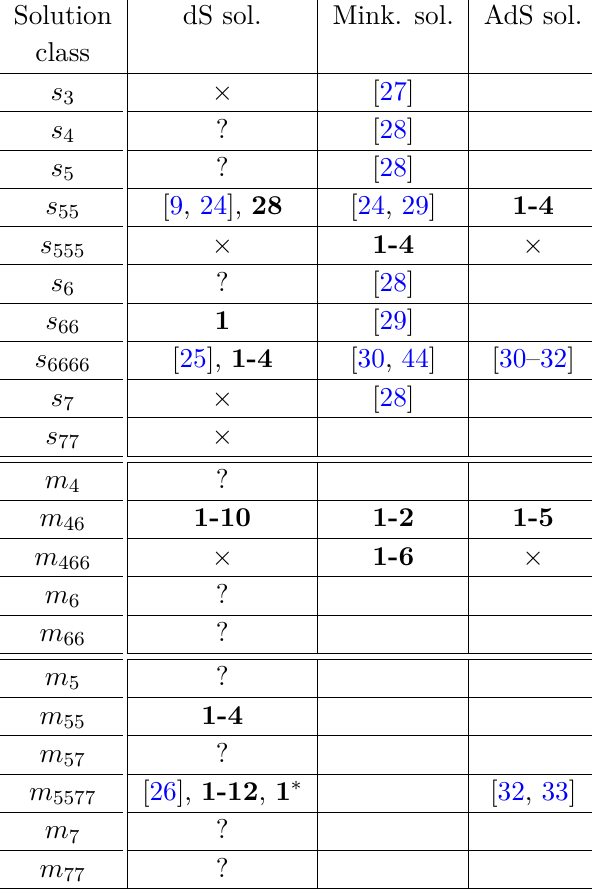
Table 8 . Solutions on a 4d maximally symmetric spacetime with orientifold that accommodate our ansatz. A reference or a number indicates that solutions have been found. A reference means that an example can be found in the corresponding paper; more references are provided in the main text. A number labels a new solution that has been found in this paper; without a reference, it means the solution is the first in its class up to our knowledge. We recall that when a solution is found in a class, it does not mean that all possible sources in the class are turned on. A cross ( × ) indicates a no-go theorem against finding a solution in a given class. A question mark means that we have searched for solutions without finding any, potentially hinting at a no-go theorem, or at computational complexity. An empty box means that we have not searched for a solution, and are not aware of corresponding solutions in the